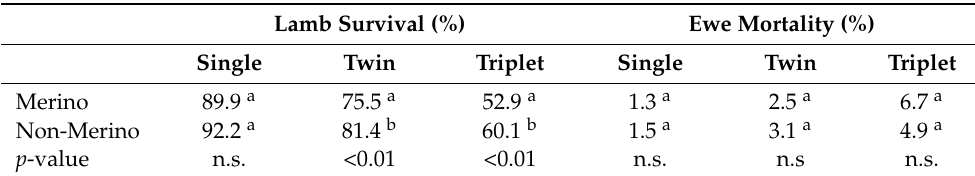
Figure 2. The proportion of twin-bearing (open circles) and triplet-bearing (solid circles) ewes relative to flock reproductive rate from survey data collected across the 2017 and 2018 breeding sesons in Australia. Raw data represents 145,000 Merino and non-Merino ewes. Table 3. Average survival of single, twin- and triplet-born lambs to marking and mortality of single, twin- and triplet-bearing ewes from pregnancy scanning to marking for Merino and non-Merino flocks where triplet-bearing ewes were managed separately from twin-bearing ewes. The data were derived from 105 flocks from 64 survey participants. Data for ewe mortality were angular transformed, and back-transformed values are